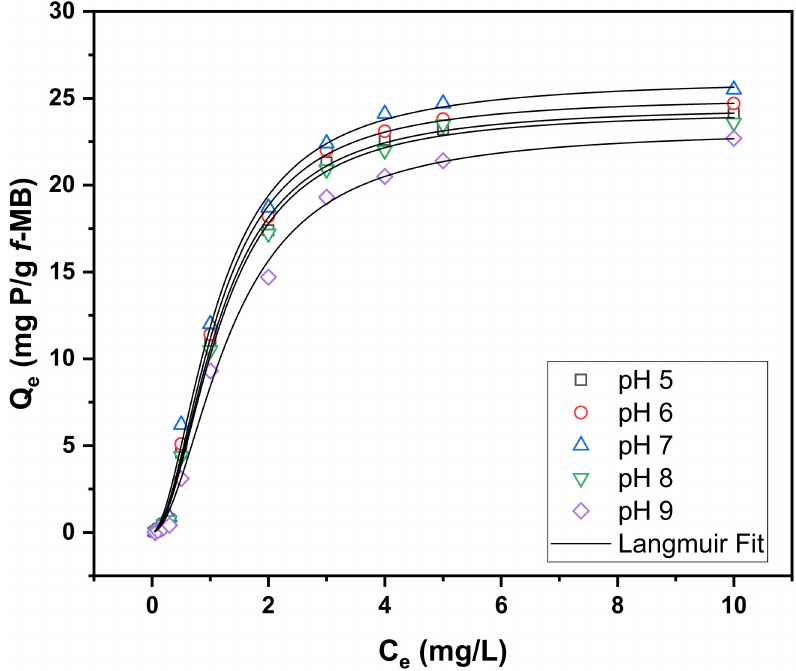
Figure 2. SEM images of innovative modified bentonite f -MB.